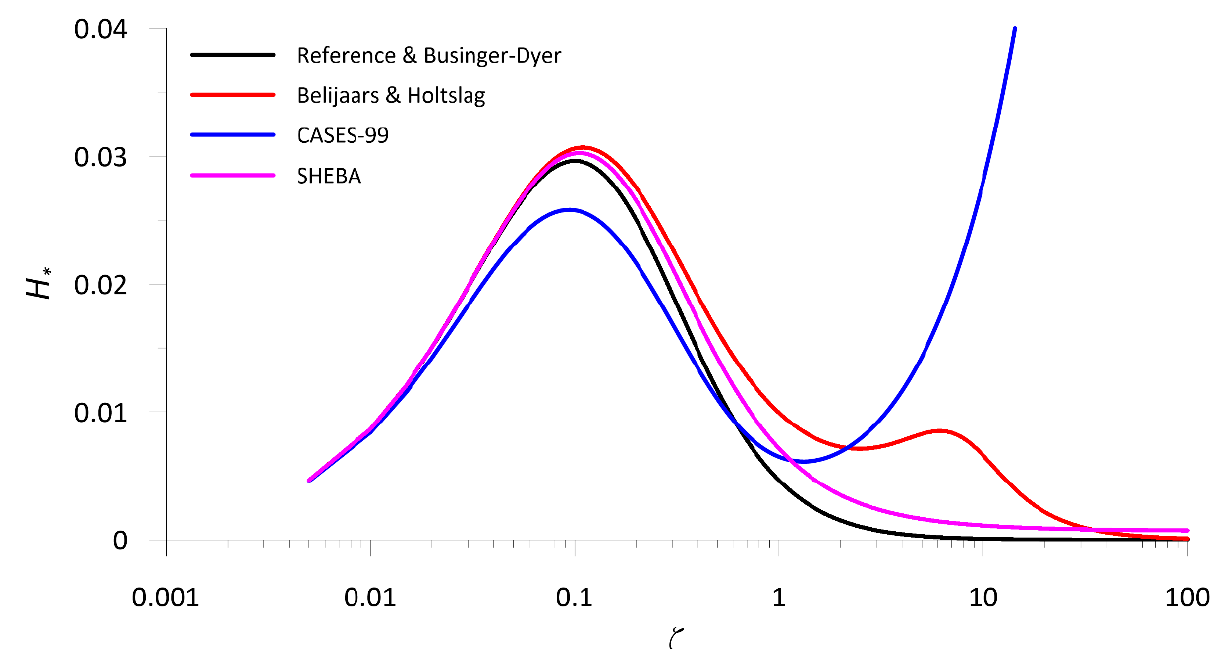
Figure 1. Evolution of 𝐻 ∗ as a function of the stability parameter 𝜁 for the four Φ (cid:3040) listed in Section 3. As a result, while all equations were capable of reproducing the expected H ∗